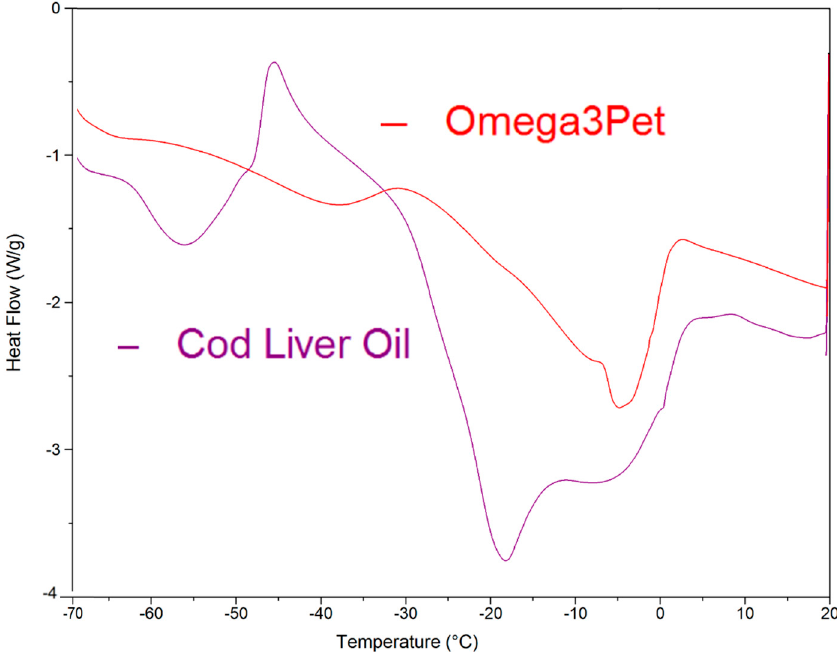
Figure 5. Linear ramp differential scanning calorimetry heat absorption data at 4 °C min − 1 for cod liver oil (CLO) and Omega-3 Pet oil (O3P; specified as anchovy and sardine).